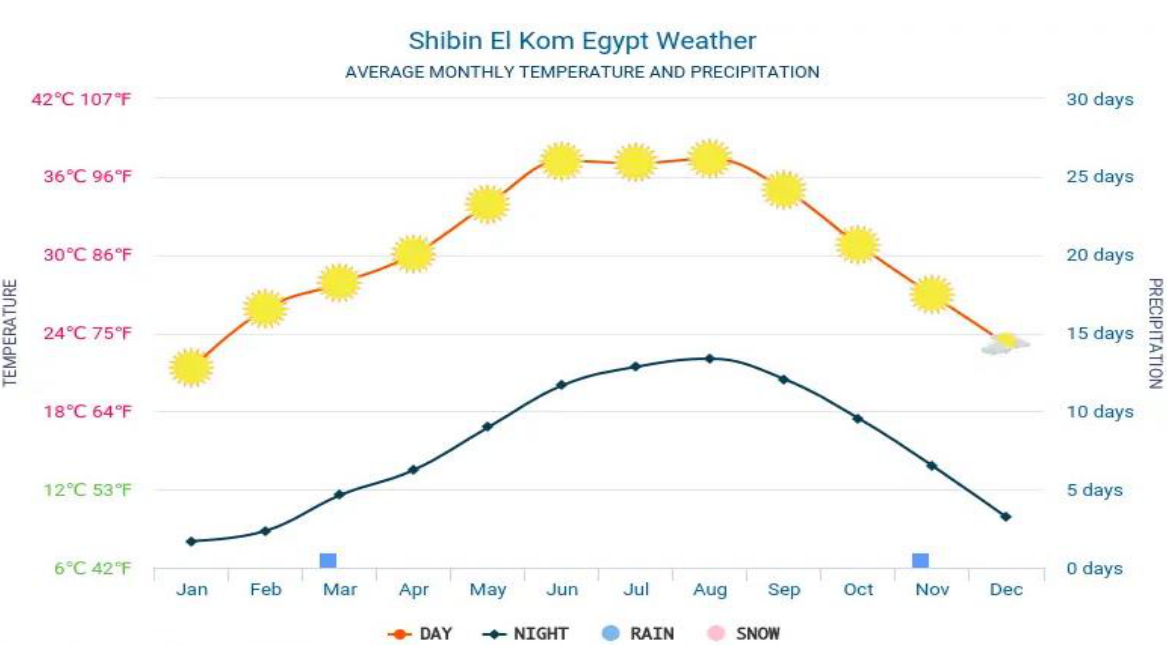
Figure 6. Variations in average values of the minimum and maximum temperatures of the ambient air for Shebin El - Kom city, Egypt during the year.